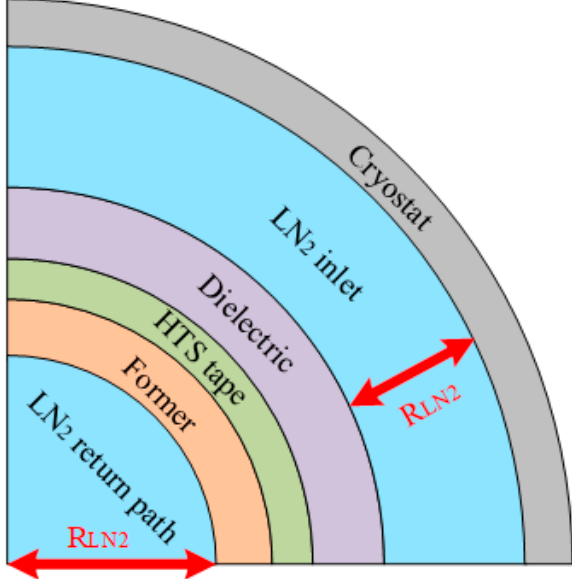
Figure 10. An illustration of fluid weight calculation in a single-layer DC HTS cable. Table 6. Analyzing the specific mass and power density of the optimally designed HTS cables.